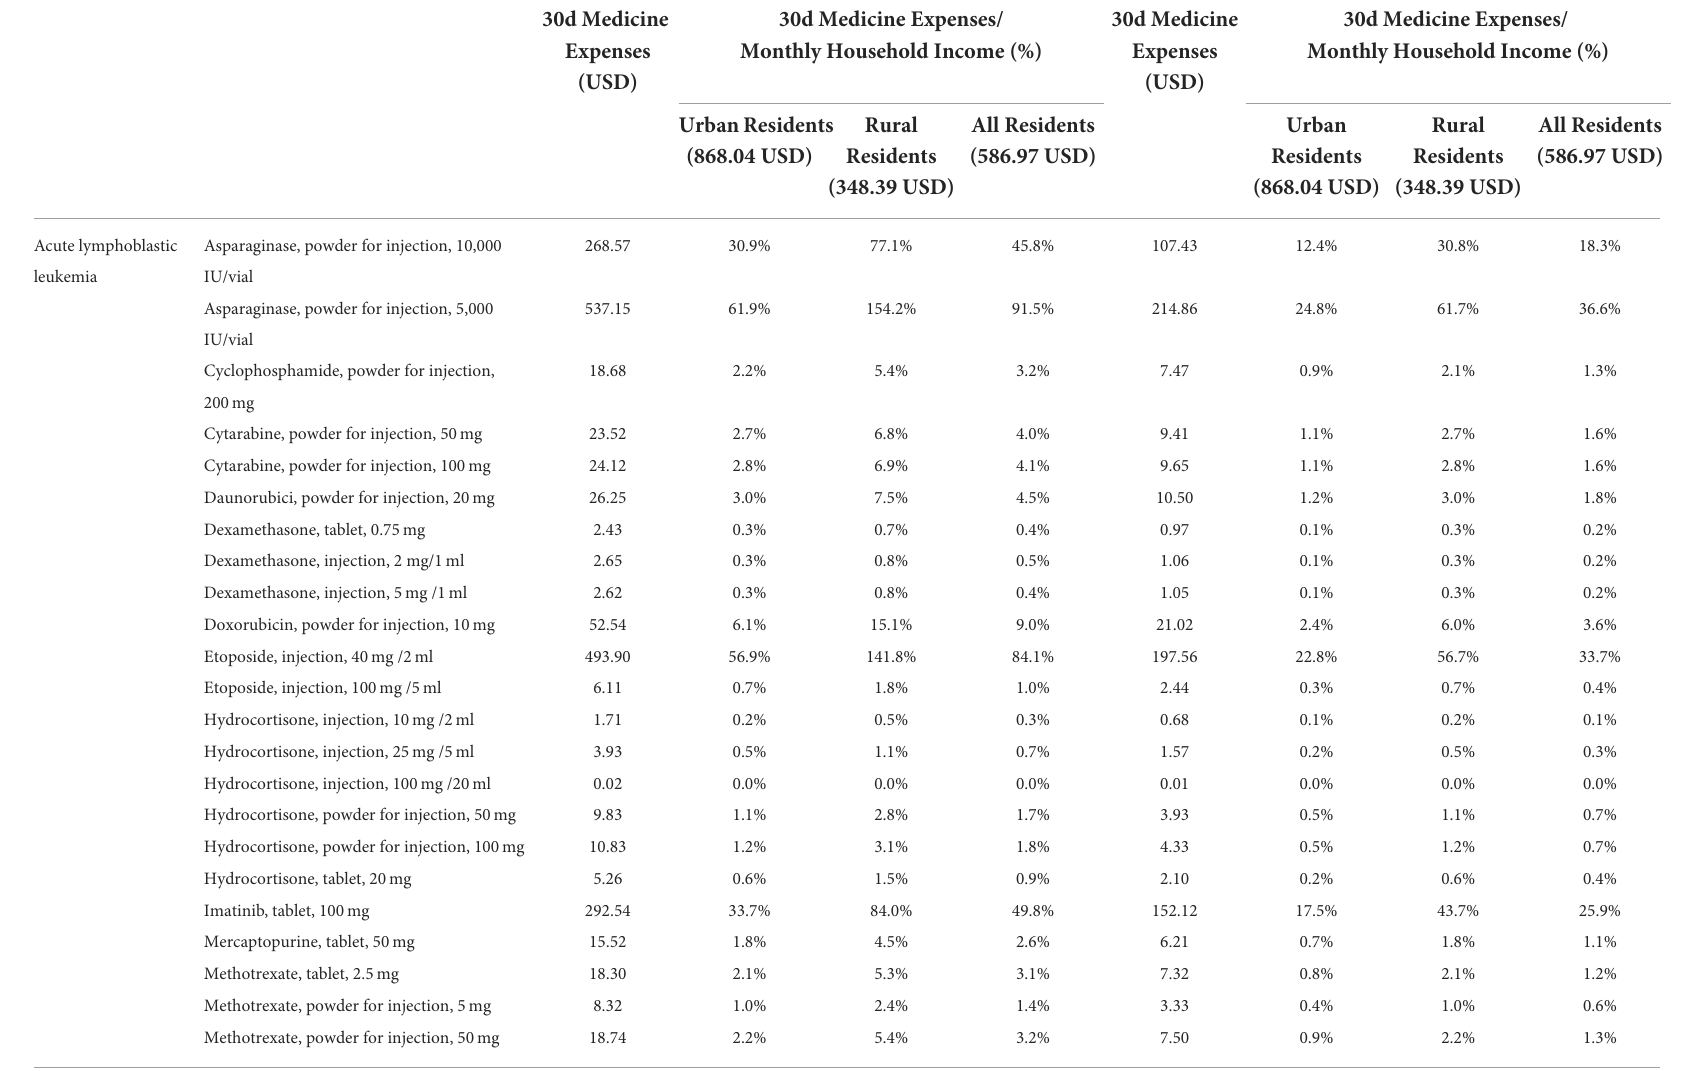
TABLE 3 Affordability of lowest-price generics before and after medical insurance